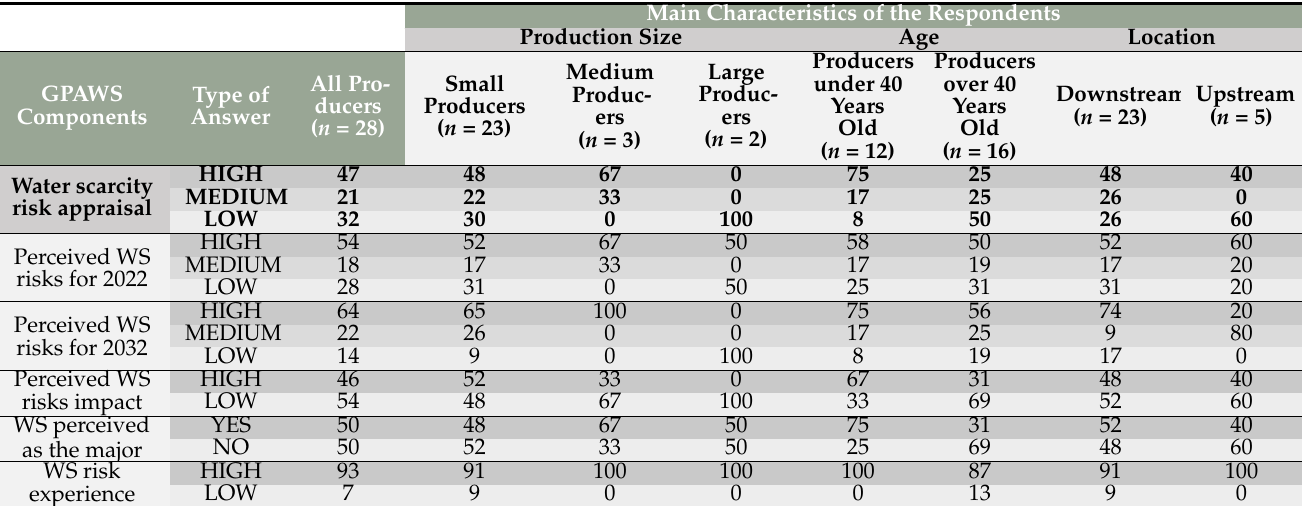
Table 2. Smallholders’ water scarcity risk appraisal in relation to their characteristics. Results represent the proportion (%) of the respondents. Main Characteristics of the Respondents Production Size